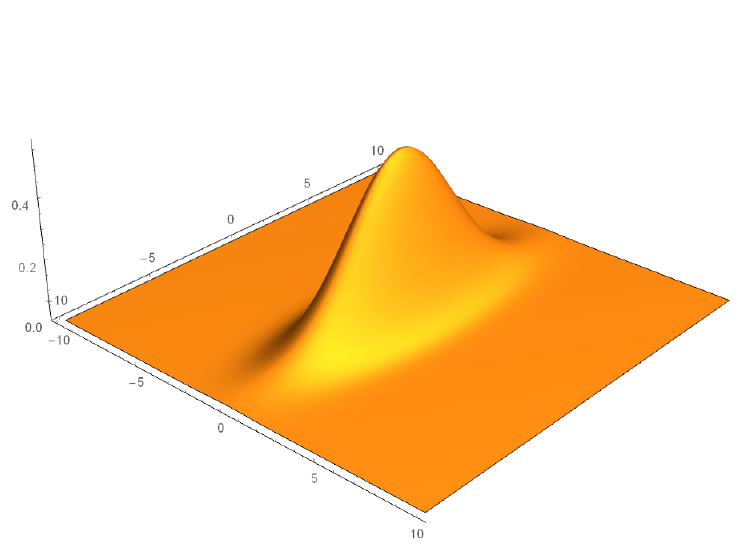
Figure 3 . Mass density pro(cid:12)le m for the black bar with (cid:10) = 0 :